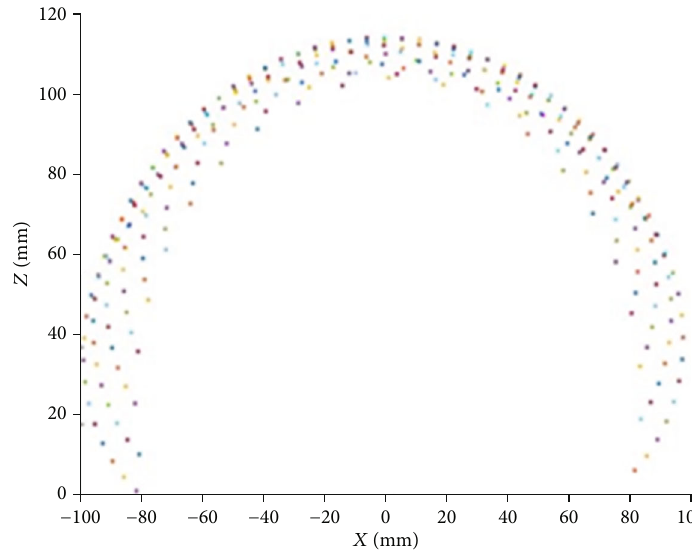
Figure 11: Three-segment catheter workspace in